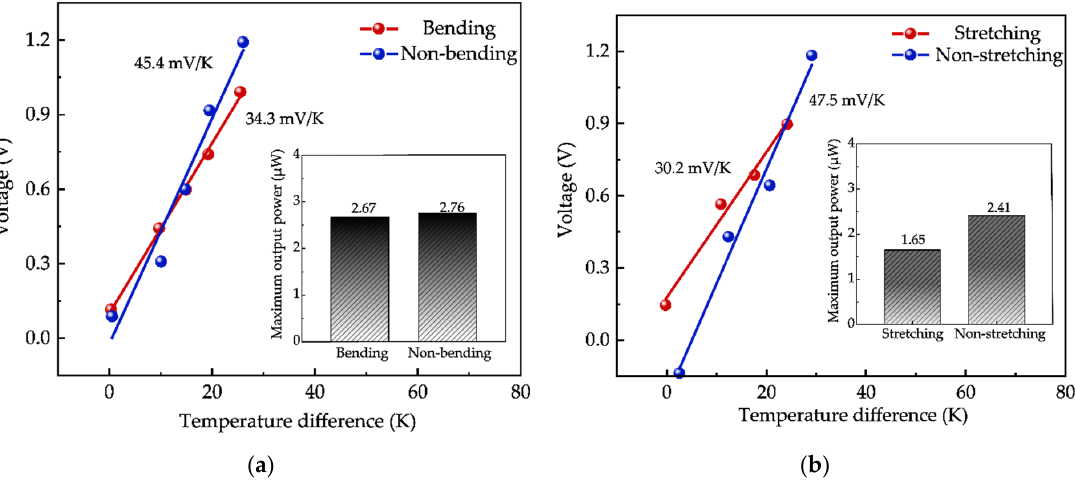
Figure 8. ( a ) The Seebeck coefficient and maximum output power of the STEG in bending/non- bending state; ( b ) the Seebeck coefficient and maximum output power of the STEG in stretching/non-stretching state.